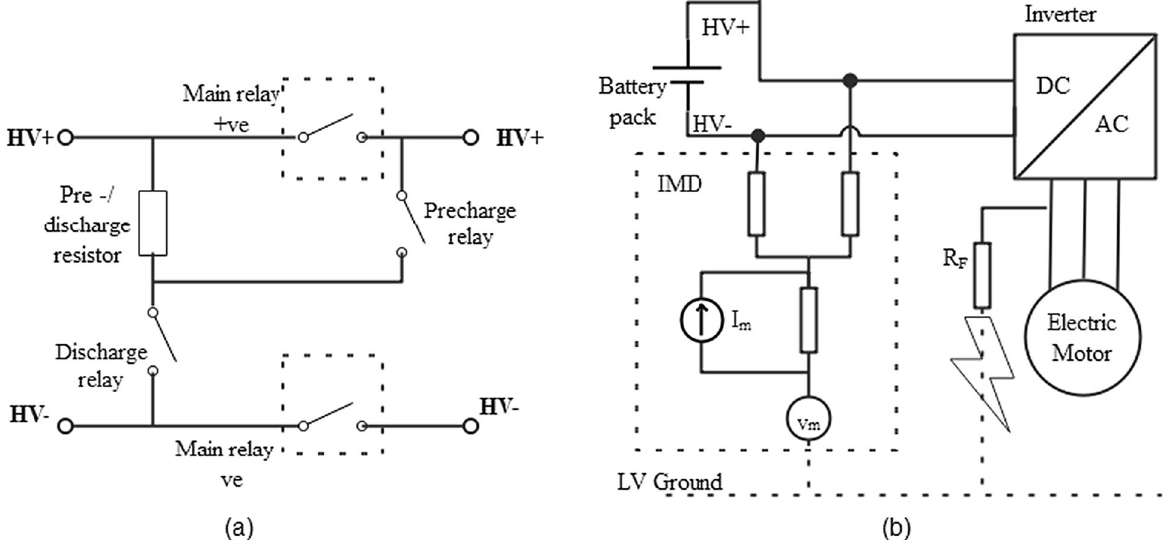
Fig. 6 High voltage system safety components: a Pole cutting relays and pre-charge/discharge circuit; b Working principle of insulation monitor- ing